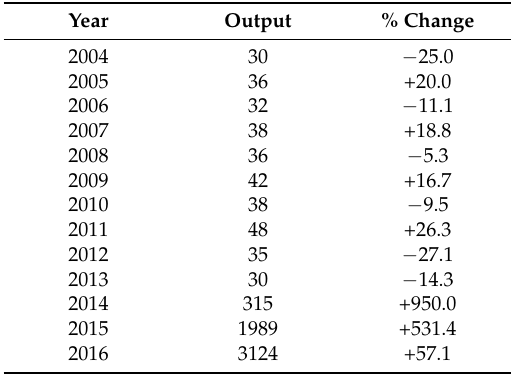
Table 1. Annual output of Medicine since 2004, and % change from previous